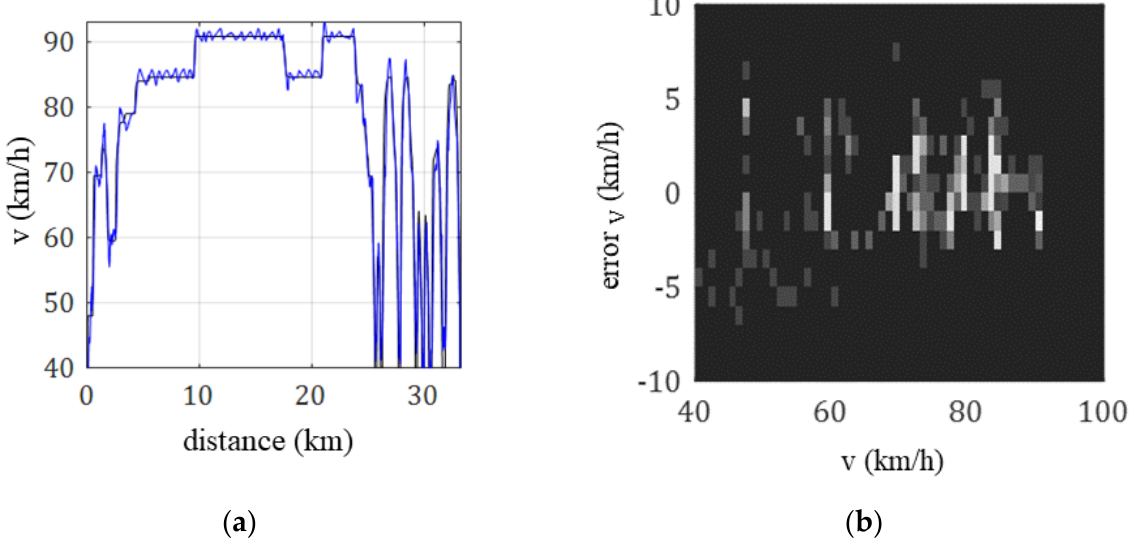
Figure 6. ( a ) Calculated (black) vs. implemented (blue) optimal speed profile for minimum fuel consumption with an average speed of 86 km/h; ( b ) Distribution of the error between measured and desired vehicle speed as a function of vehicle speed. The colours scale shows the probability from white (high) to black (low).